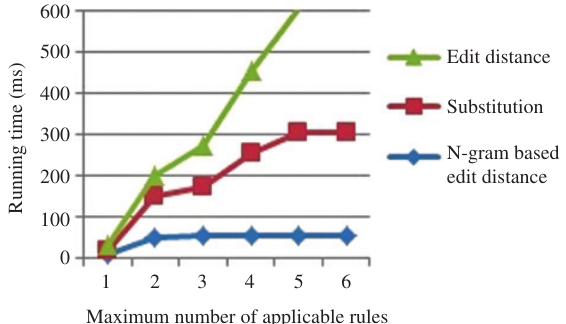
Figure 9: Effect of Number of Rules in Various